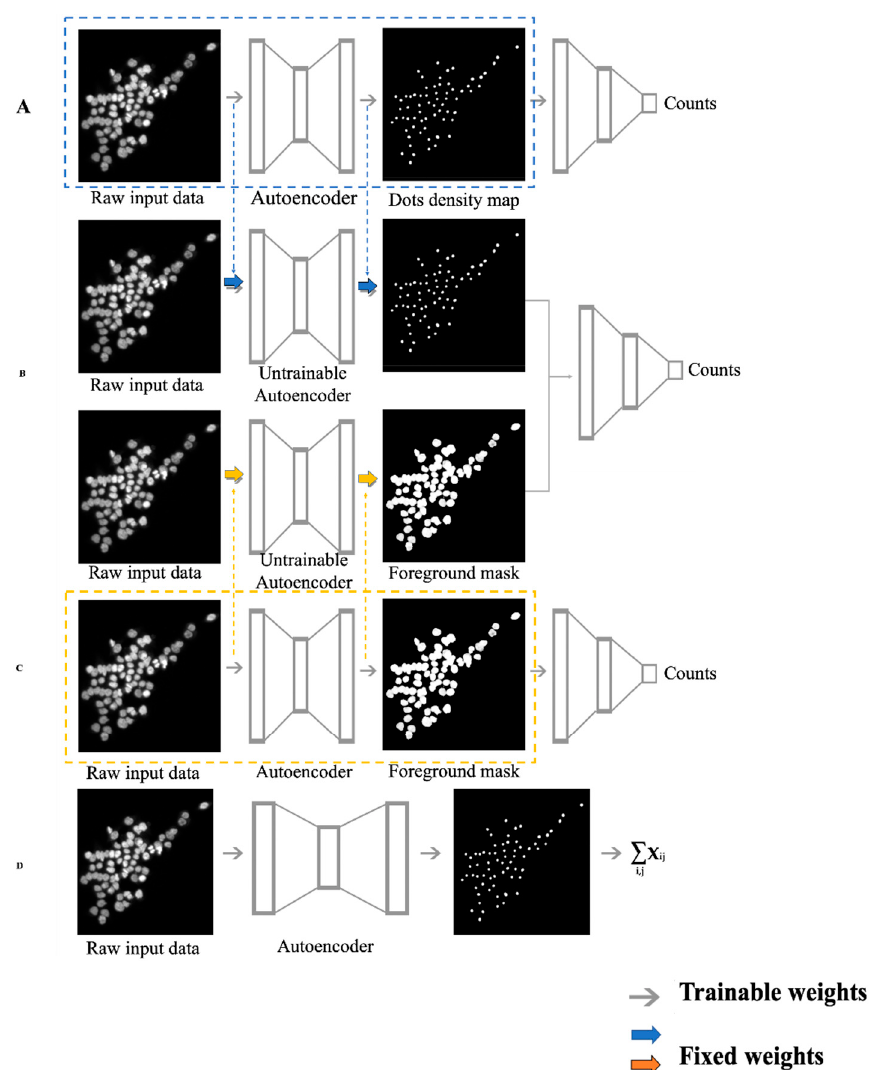
Figure 1. The workflow of the four deep convolutional neural network (DCNN) models used in this study. Gray arrows are trainable weights in the models. Colored arrows represent the weights inherited from previous well-trained feature extraction models. ( A ) Dot-density-map-based regression DCNN (DRDCNN). It contained two parts: feature extraction autoencoder (dashed box) and regression parts. The blue dashed arrows represent the well-trained weights, which can be loaded into the end-to-end counting regression model. ( B ) Ensembling-based regression DCNN (ERDCNN). Colored arrows represent the weights inherited from the two previous well-trained feature extraction models. ( C ) Foreground-mask-based regression DCNN (FRDCNN). It contained feature extraction autoencoder and regression parts as well. The orange arrows represent the well-trained weights which can be transferred into the ensemble regression model. ( D ) Density-only DCNN (DDCNN). This model first trained an autoencoder to extract a dot density map from a microscopic image, then summed the pixel values up in the dot density map to get the estimated cell count without any regression process.